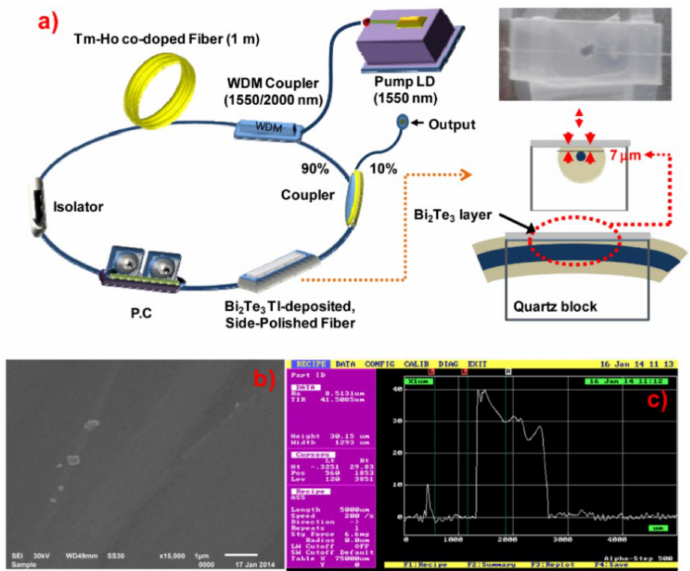
Figure 11. ( a ) The laser schematic. ( b ) Measured SEM image of the mechanically exfoliated, thick Bi 2 Te 3 layer. ( c ) Bi 2 Te 3 layer depth measurement result using an alpha step profiler. Reprinted with permission from [66].